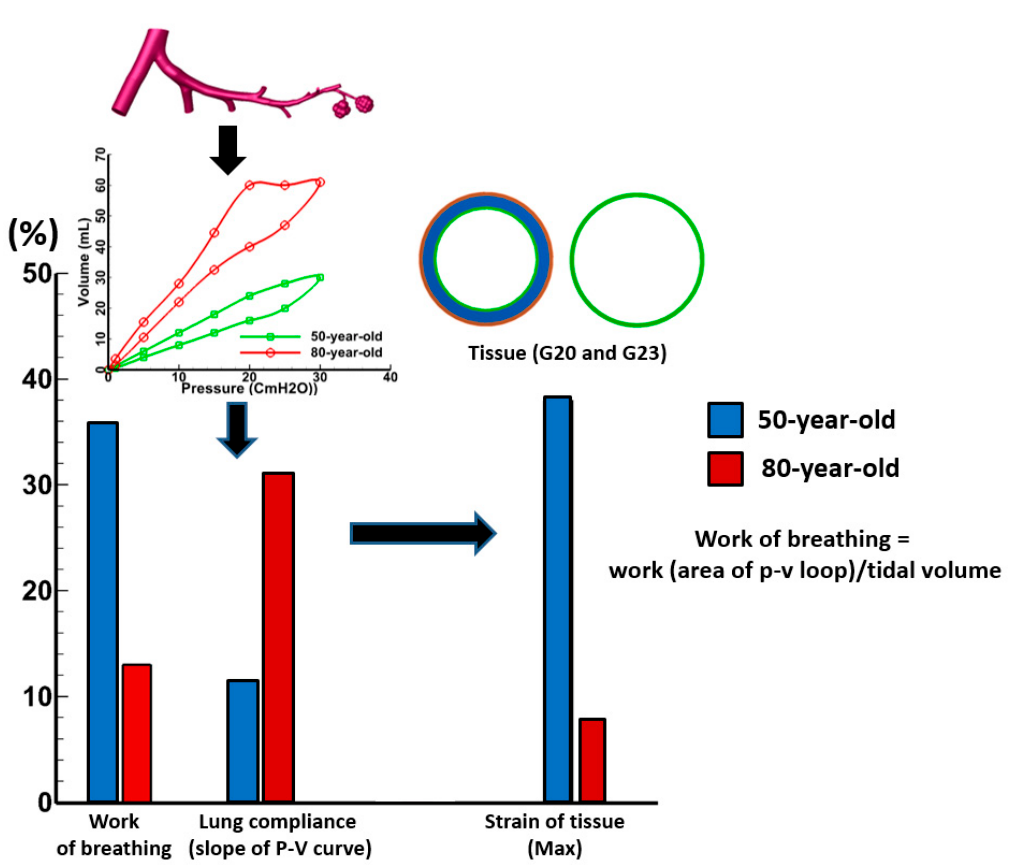
Figure 11. Comparison of respiratory mechanics parameters (work of breathing, compliance, and tissue strain) for the 50 ‐ year ‐ old and the 80 ‐ year ‐ old.